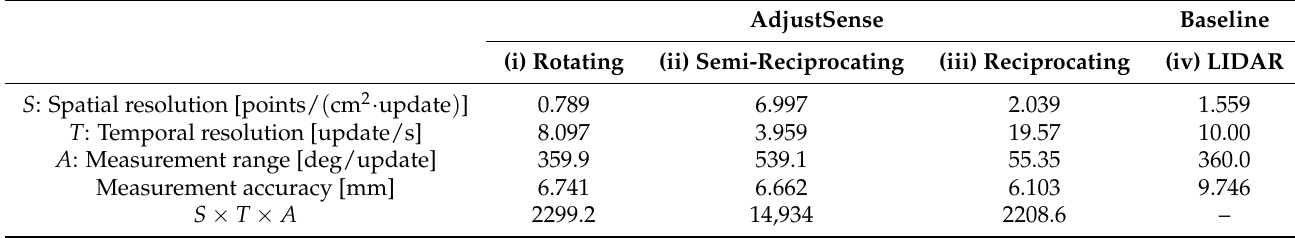
Figure 11. Measured 3D points on fixed plastic board in three control modes of AdjustSense and LIDAR, which were obtained from 20 updates of 3D measurement. Color bar indicates distance defined as measurement error which is from output plane when point cloud is applied to plane fitting. Table 1. Spatio-temporal resolution, measurement range, and measurement accuracy in three control modes of AdjustSense and LIDAR calculated with 3D point obtained from fixed plastic